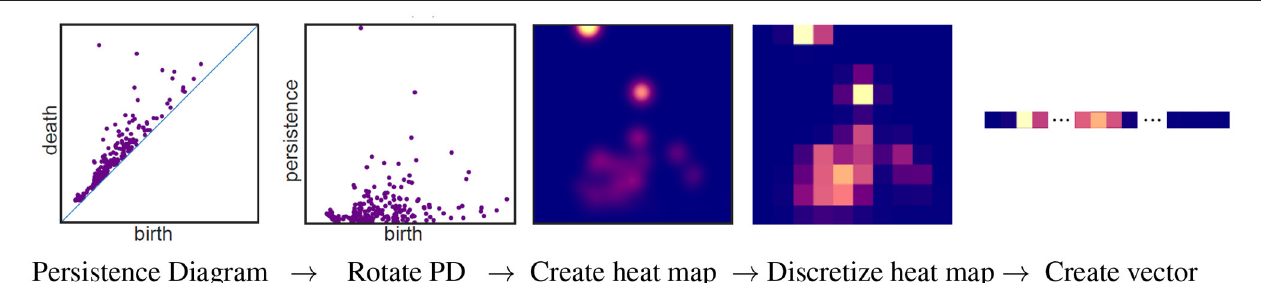
FIGURE 5 | Pipeline for vectorizing a persistent diagram using persistent images. This figure is a modification of Figure 1 from Adams et al. (2017) which is licensed under CC BY 4.0.